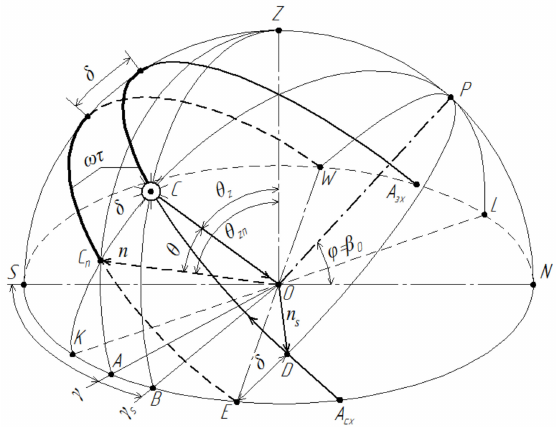
Figure 14. Scheme for measuring of the parameters of irradiation of the tracking surface of a polar- rotating tracker—designed based on